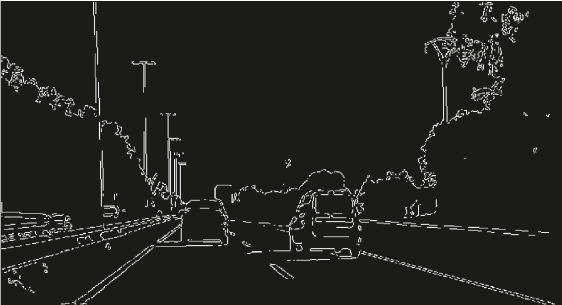
Figure 2: Resulting image using the Canny edge detector.